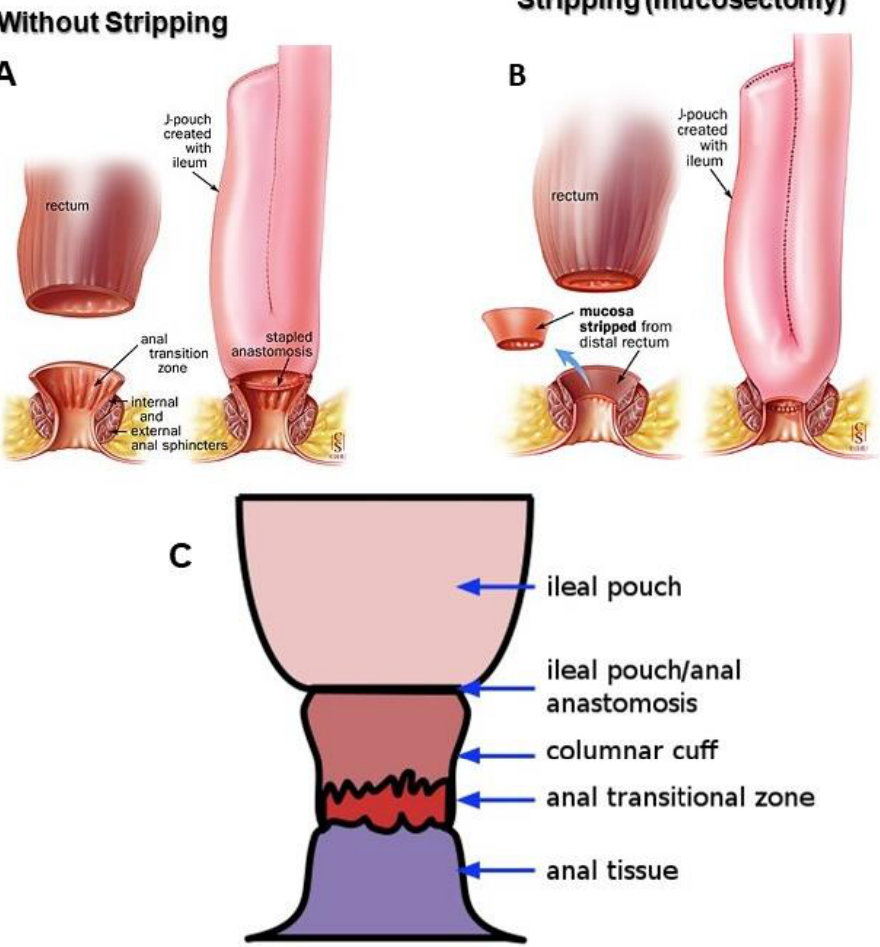
Figure 1. Restorative proctocolectomy with ileal pouch-anal anastomosis. ( A ) J-stapled double staples anastomosis and ( B ) handsewn anastomosis with mucosectomy. Reprinted/adapted with permission from M’Koma et al. [12]. Copyright © 2007, Springer-Verlag. ( C ) Columnar cuff: cuff inflammation is a common complication of RPC-IPAA, especially when a towed anastomosis has been used without mucosectomy. Reprinted/adapted with permission from Ref. [89], Copyrights © 2003 by the American Gastroenterological Association and © 2010 by Thieme Medical Publishers, Inc. from Ref. [90].